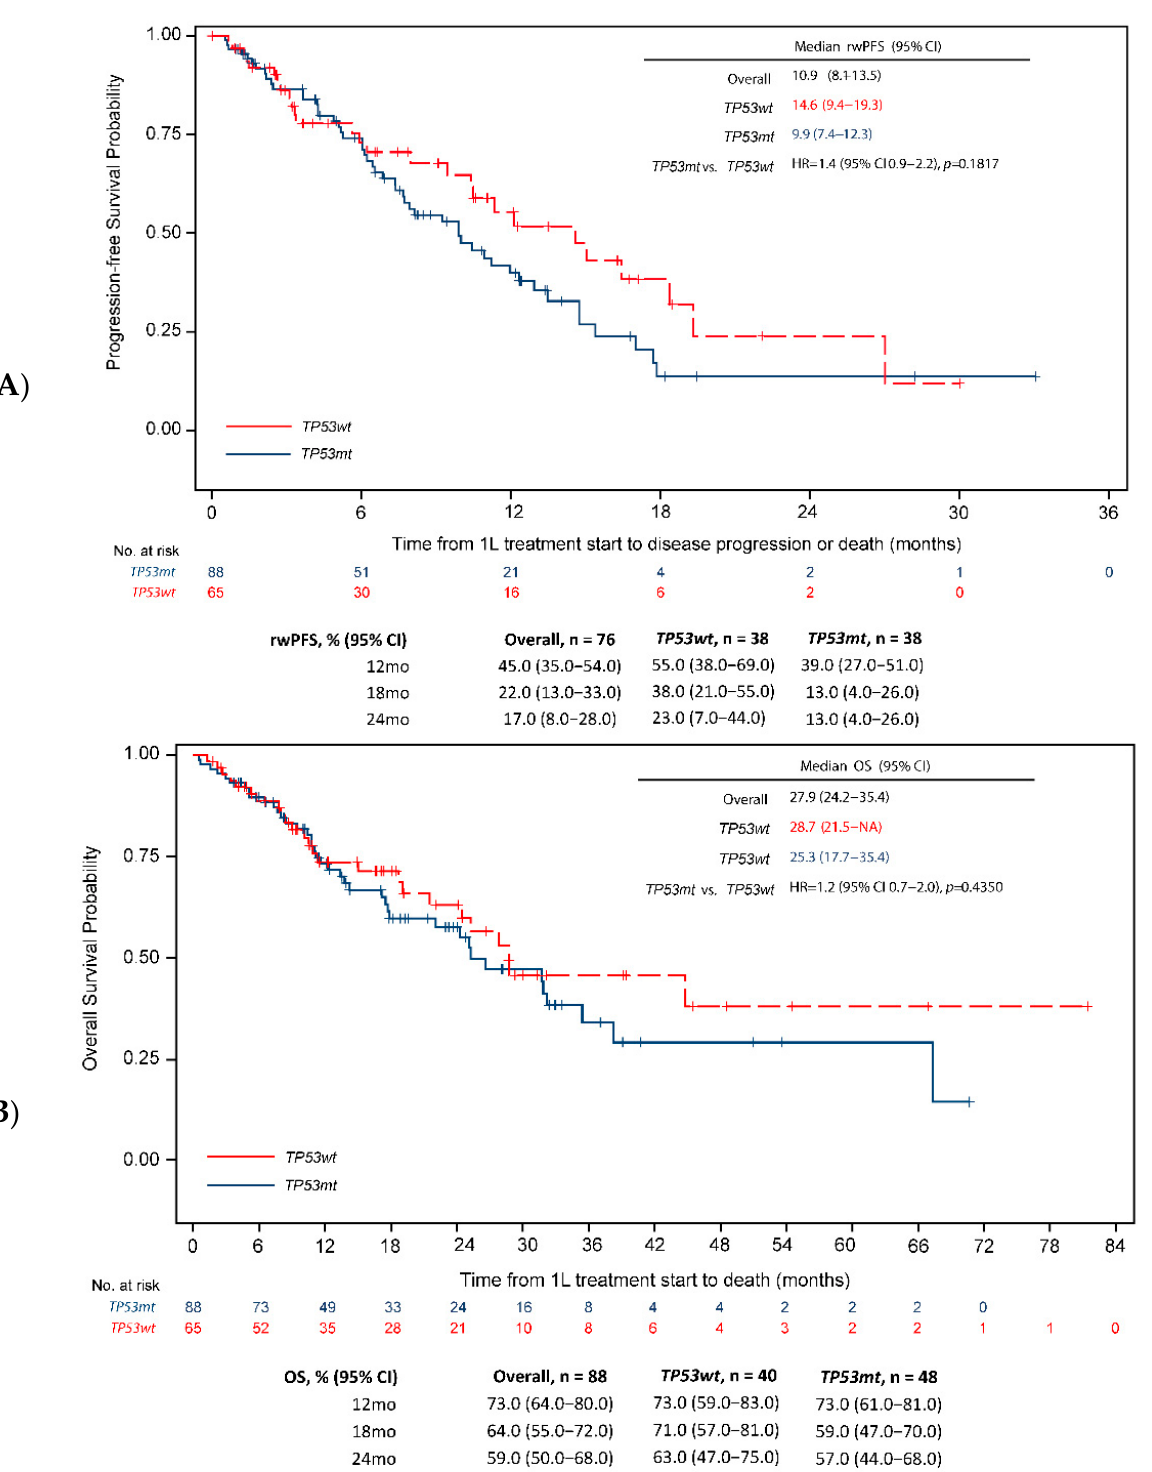
Figure 4. rwPFS and OS— TP53 co-mutation vs. TP53 wild-type by Exon21L858R mutation. ( A ) rw- PFS. ( B ) OS. Unadjusted HR and 95% CI. CI = confidence interval; HR = hazard ratio; OS = overall survival; rwPFS = real-world progression-free survival; TP53mt = TP53 co-mutation; TP53wt = TP53 wild-type; exon 21 = exon 21L858R mutations.